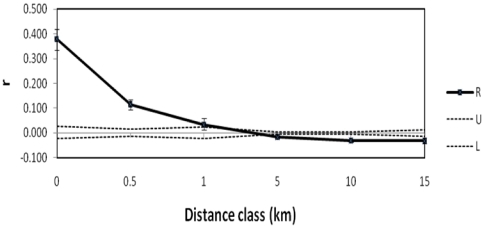
The distribution of genotypic similarity (r) with geographic distance (kilometres) for immature lizards.The solid line tracks relatedness, dashed lines represent the upper (U) and lower (L) 95% confidence interval around random expectations while bars around R show the 95% confidence interval around this estimate determined by bootstrapping. The distance class of 0 kilometres contains the r estimate among individuals sharing the same burrow system.